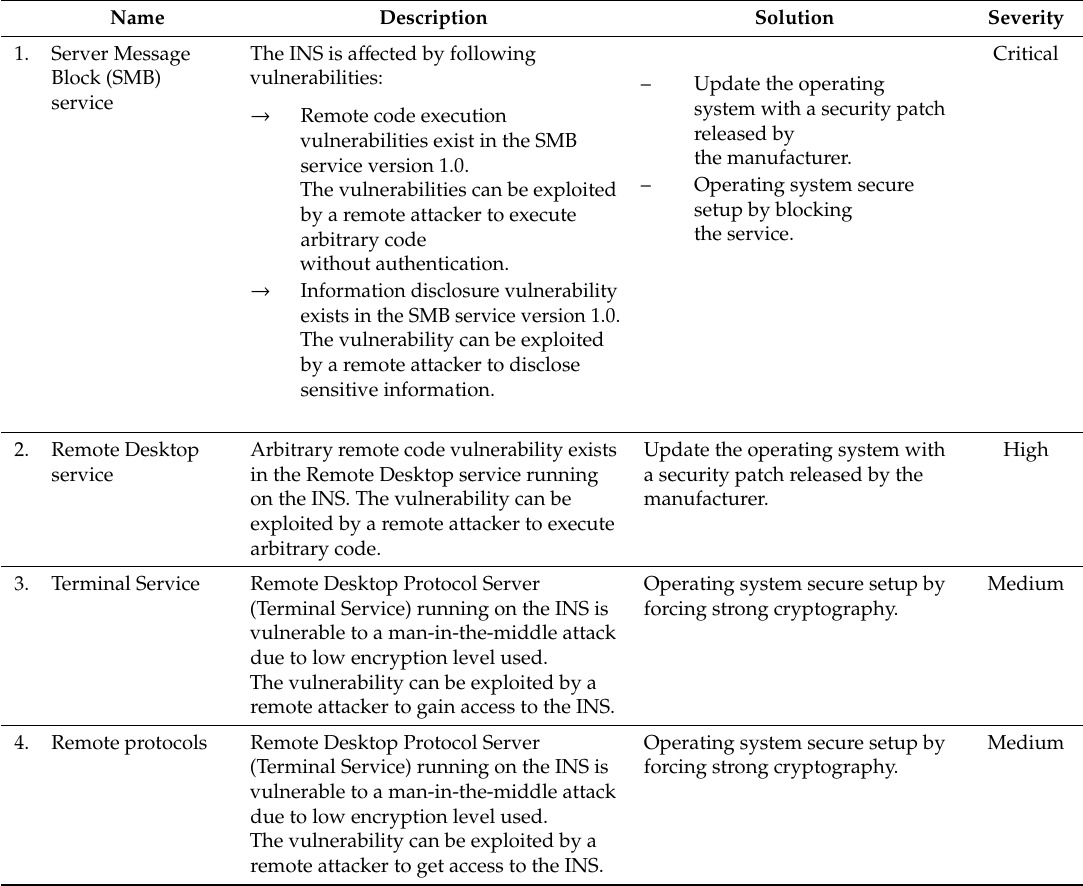
Table 3. Results of the vulnerability